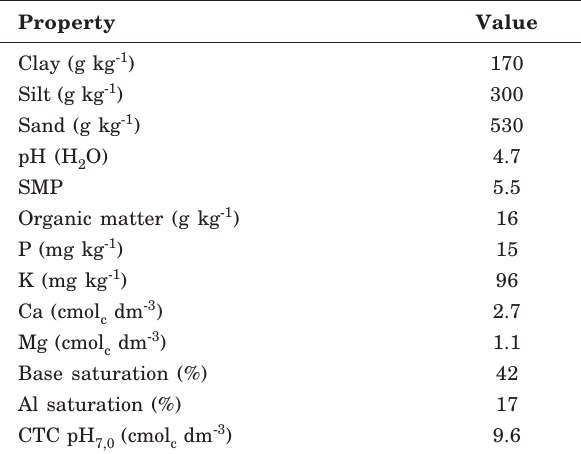
Table 1. Soil physical and chemical properties before the